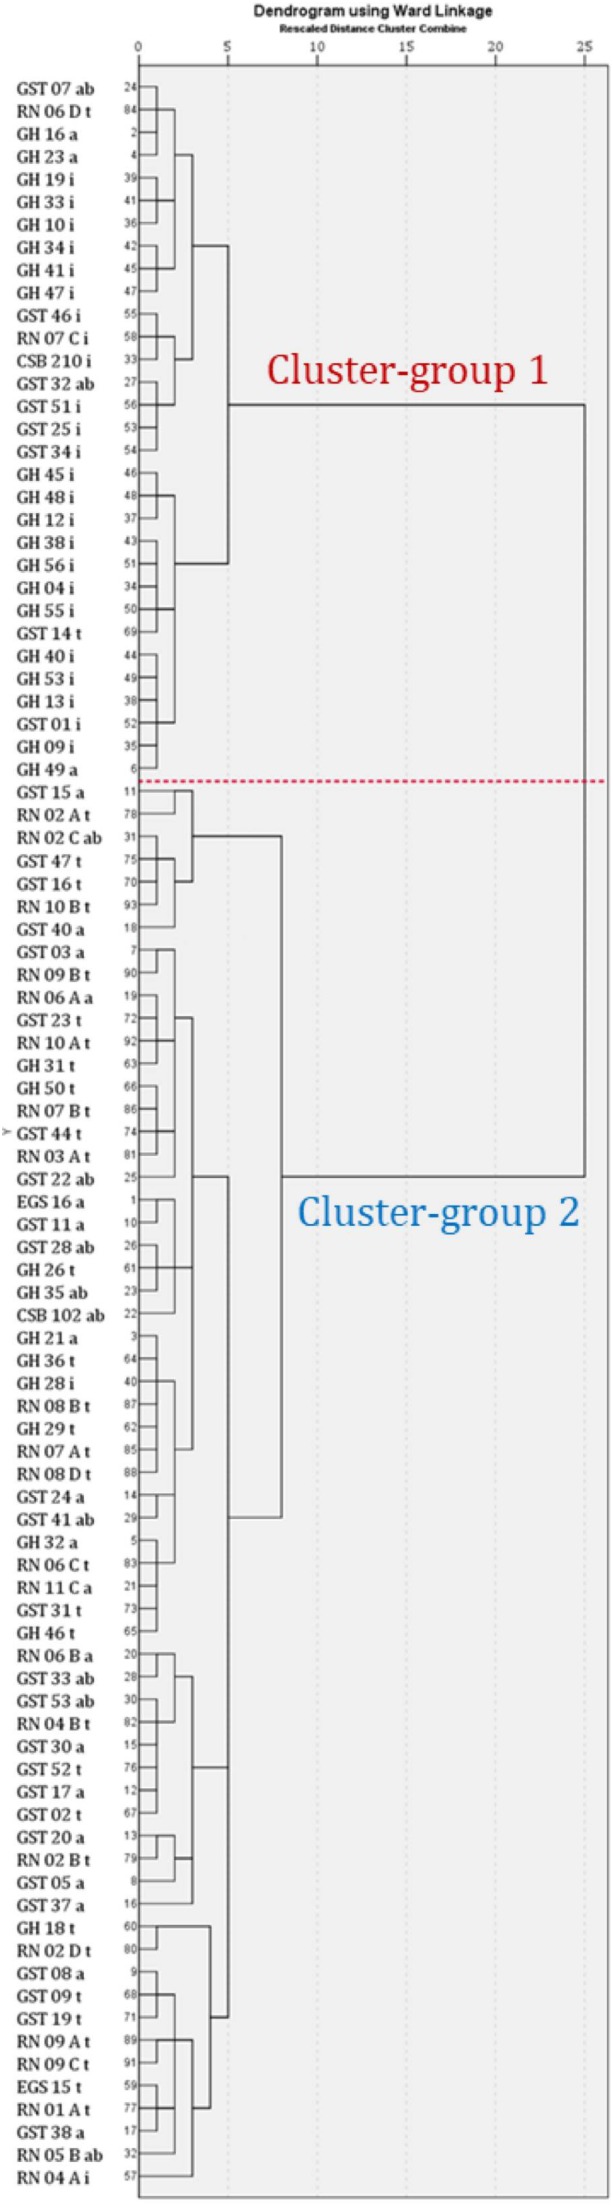
Cluster analysis of 93 metabolite profiles of Alternaria species-groups isolates. The dendrogram is based on a hierarchical cluster analysis with Euclidean distance and Ward linkage. Isolates’ names consist of a code of country (first capital letter; G, Germany; R, Russia), region (capital letter; H, Helpt; N, Novosibirsk; St, Steinfurth), identification number and sporulation group (a: A. alternata; ab, A. arborescens; i, A. infectoria; and t, A. tenuissima) (Supplementary Table S1).